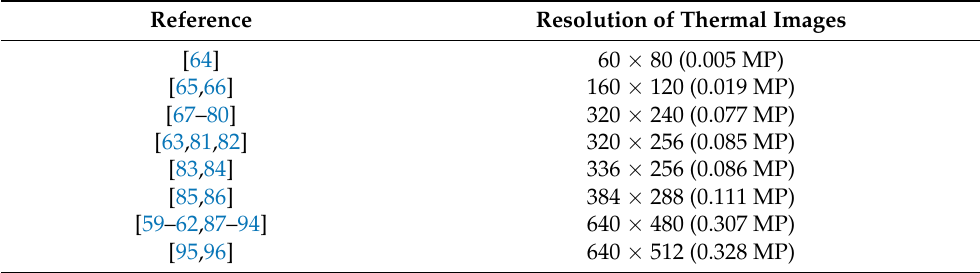
Table 1. Resolution of thermal images used for detection in livestock